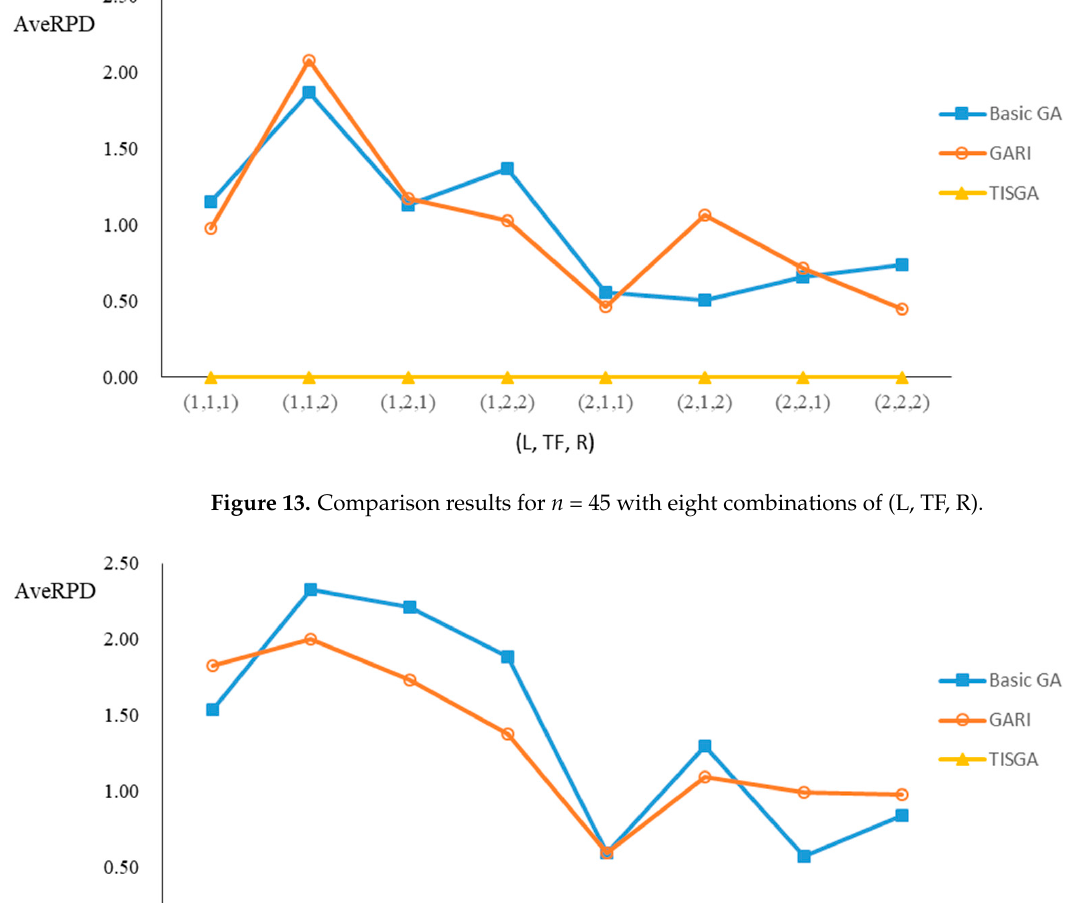
Figure 12. Comparison results for n = 40 with eight combinations of (L, TF, R).